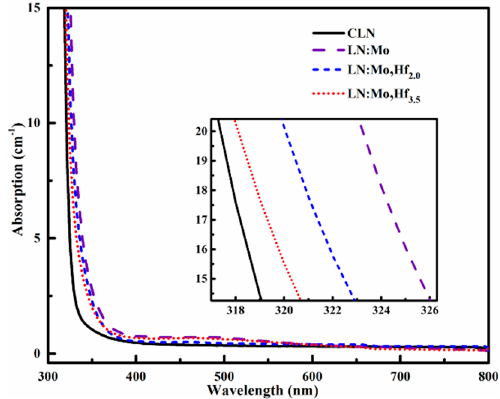
Figure 3. Absorption spectra of LN: Mo, Hf and congruent LN crystals, while the inset is the absorption spectra near the absorption edge.